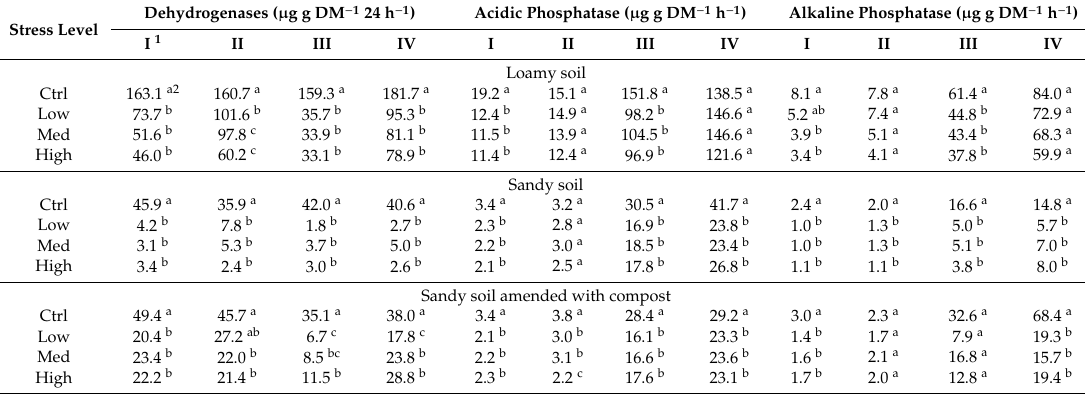
Table 3. Soil enzyme activities as dependent on soil moisture and water